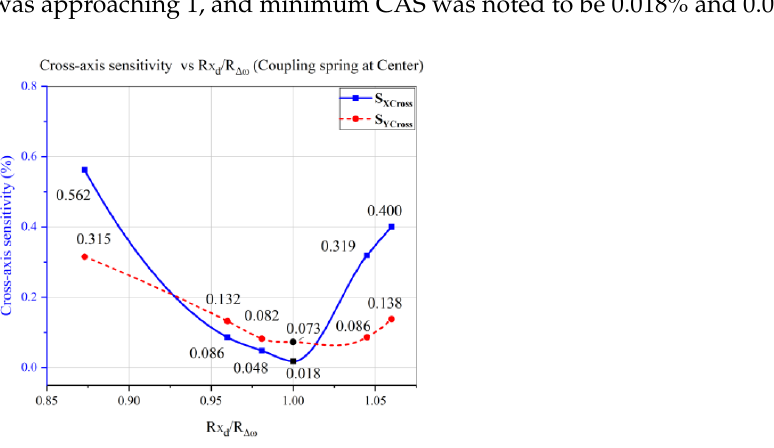
Figure 10. Cross-Axis Sensitivity vs. 𝑅 𝒙 MEMS Gyroscope Gyroscope.